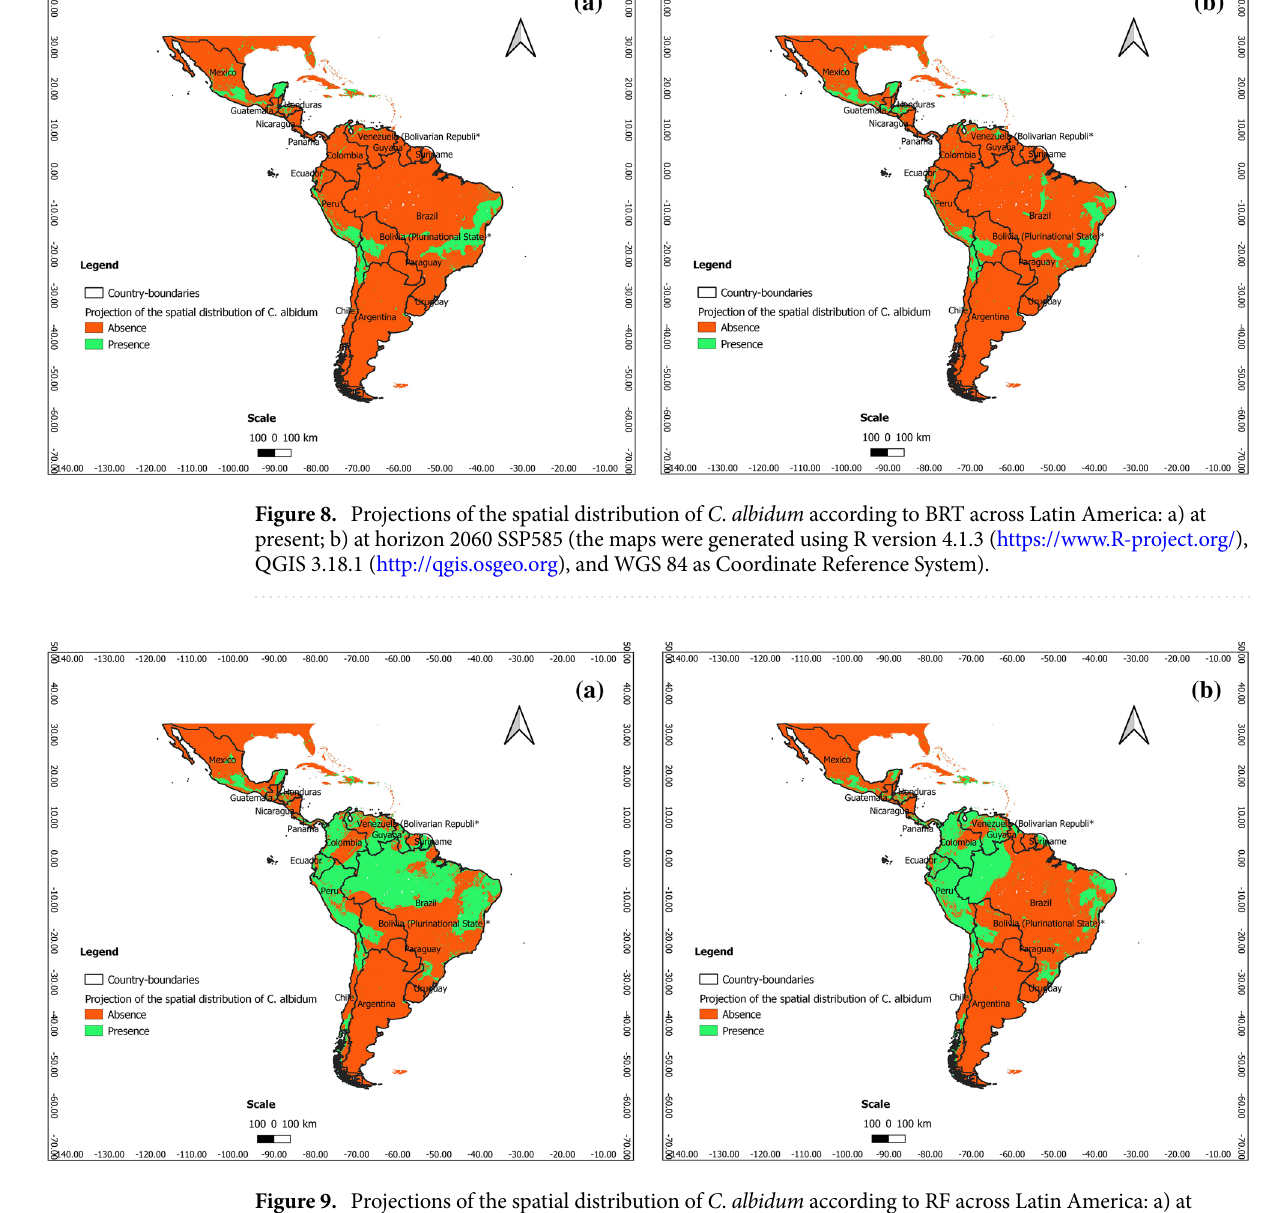
Figure 9. Projections of the spatial distribution of C . albidum according to RF across Latin America: a) at present; b) at horizon 2060 SSP585 (the maps were generated using R version 4.1.3 (https:// www.R- proje ct. org/), QGIS 3.18.1 (http:// qgis. osgeo. org), and WGS 84 as Coordinate Reference